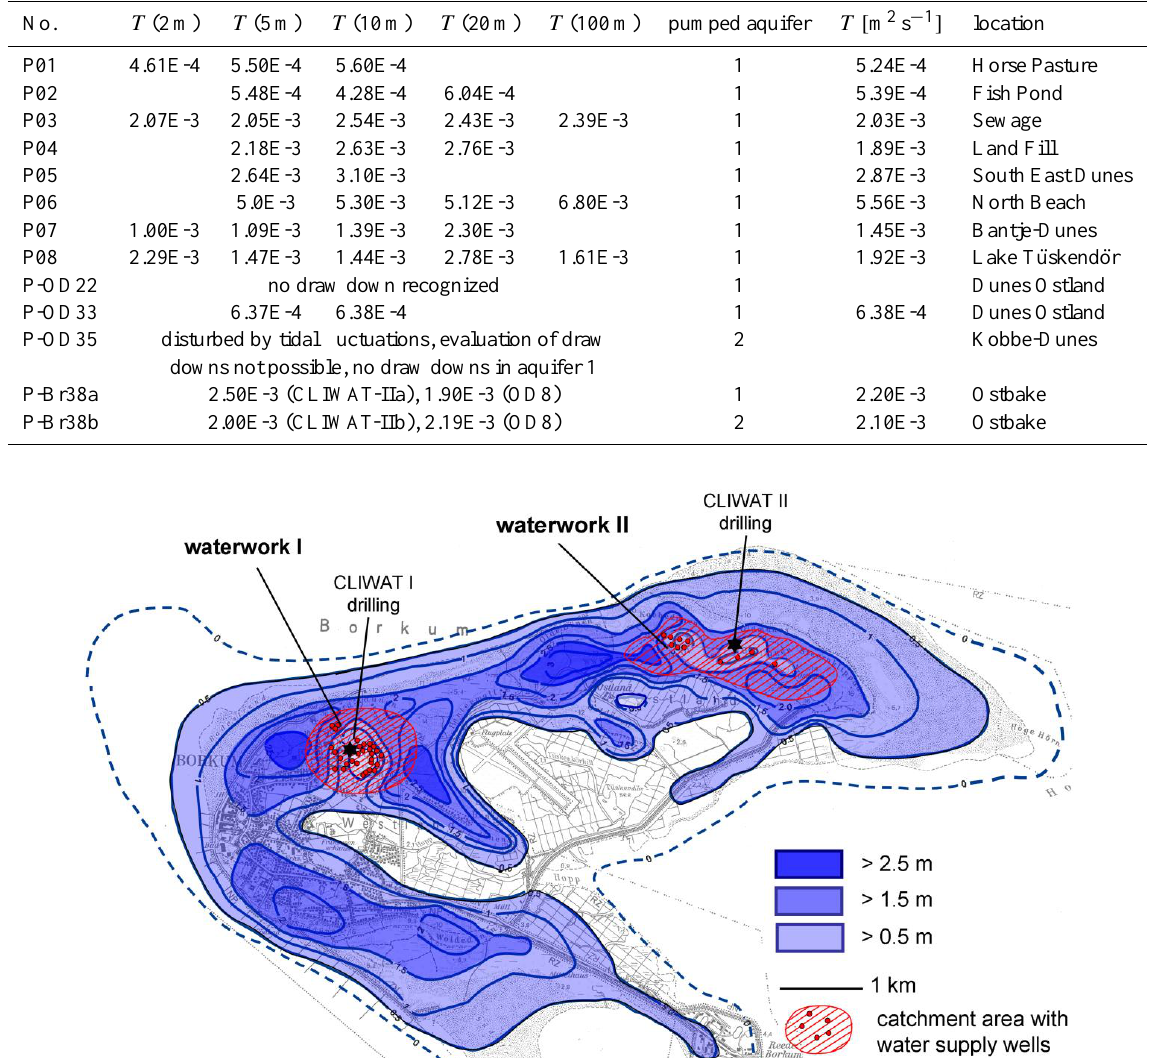
Table 1. Transmissivity ( T ) obtained from pumping tests. According to the configuration of the pumping test for all locations of the loggers in the draw down area with 2, 5, 10m (and so on) distance to the pumping location, transmissivities T (2m), T (5m), T (10m) (and so on) were computed and averaged to one transmissivity T at the pumping location.